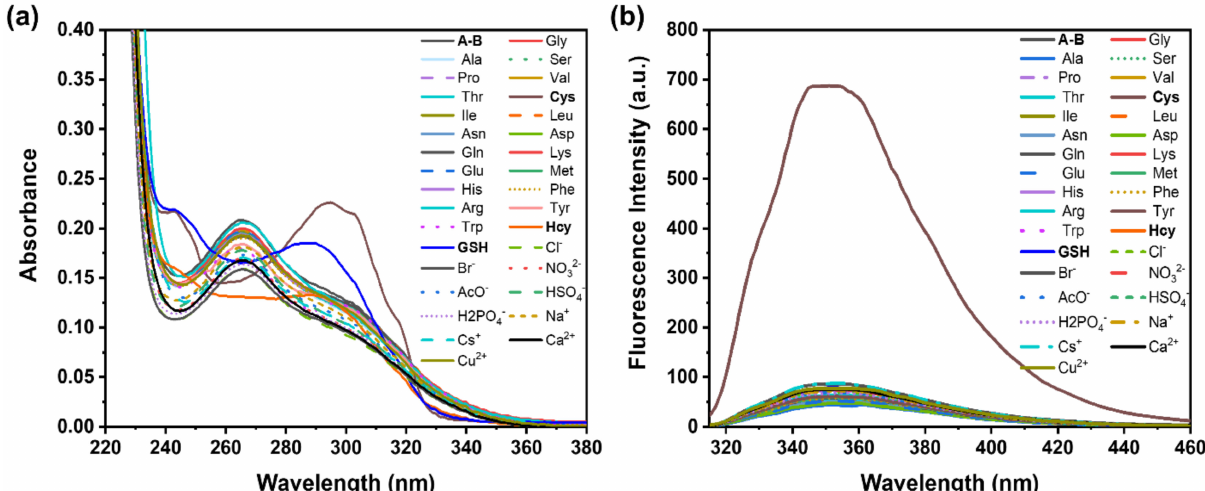
Figure 3. ( a ) Changes in UV − vis absorption spectra and ( b ) fluorescent intensity ( λ ex = 303 nm, λ em = 350 nm) of A-B (10 µ M) upon addition of 5 equivalents of other analytes (50 µ M) in 1 mM HEPES buffer at room